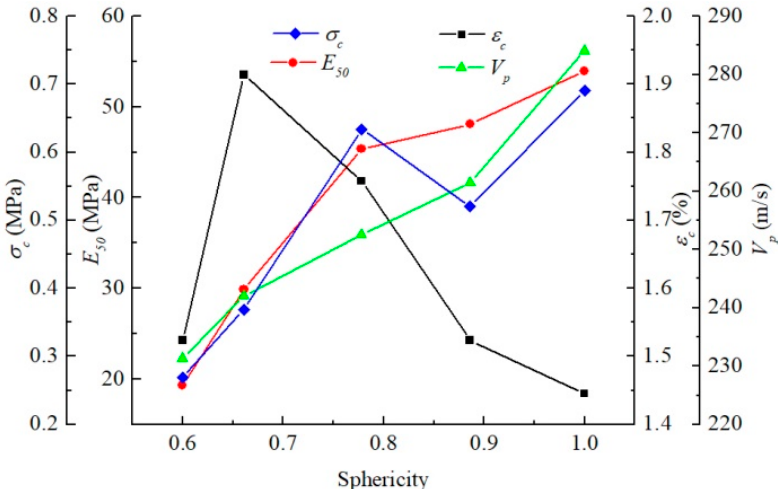
Figure 17. Relationship between pore sphericity and macroscopic static and dynamic parameters.